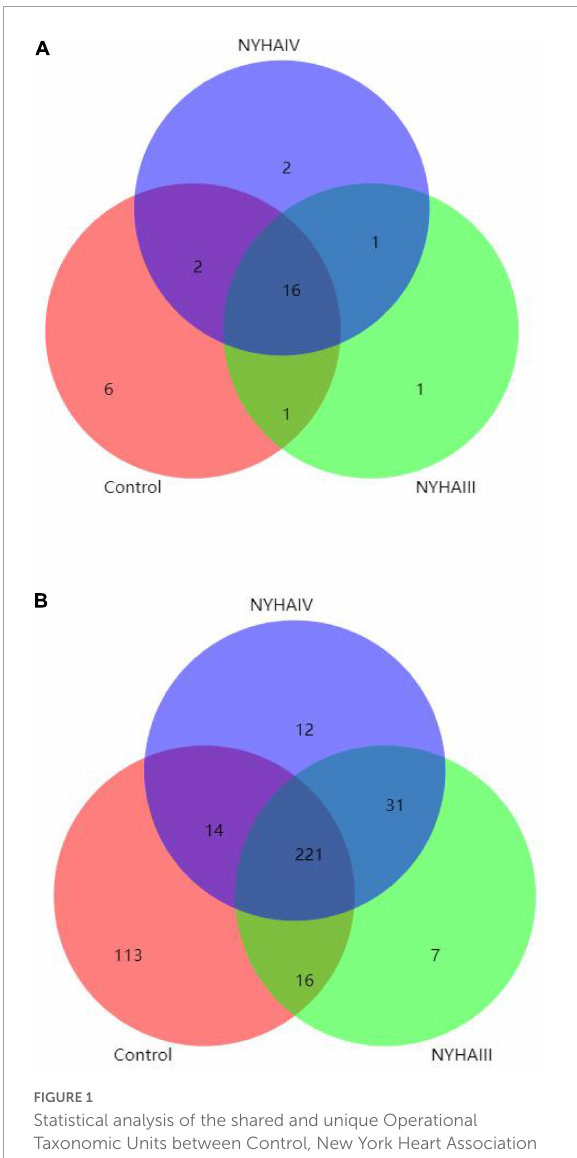
FIGURE1 Statistical analysis of the shared and unique Operational Taxonomic Units between Control, New York Heart Association (NYHA) class III, and NYHA class IV. (A) Phylum level. (B) Genus